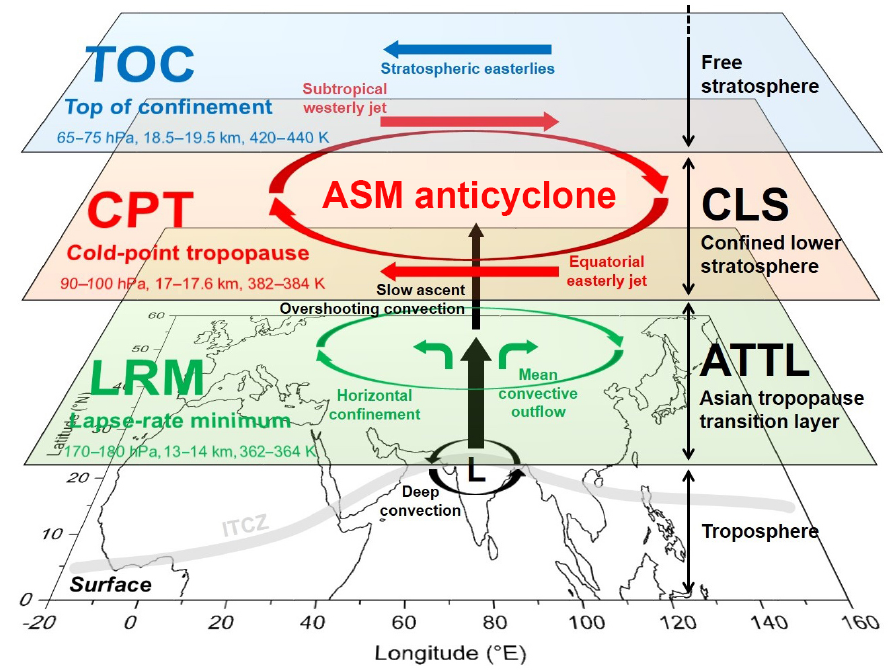
Figure 6. Schematics of the vertical structure of the UTLS above the southern slopes of the Himalayas. The Asian summer monsoon anticyclone (ASMA) consists of two layers, the Asian tropopause transition layer (ATTL) and the confined lower stratosphere (CLS). These layers are confined by three levels: the lapse-rate minimum (LRM, green surface), the cold-point tropopause (CPT, red) and the top of confinement (TOC, blue). Dynamical features and relevant transport processes discussed in the paper are also sketched. Approximated pressure, altitude and potential temperature levels of the TOC, CPT and LRM derived from NT16 AUG and DK17 measurements are displayed on the respective surfaces.